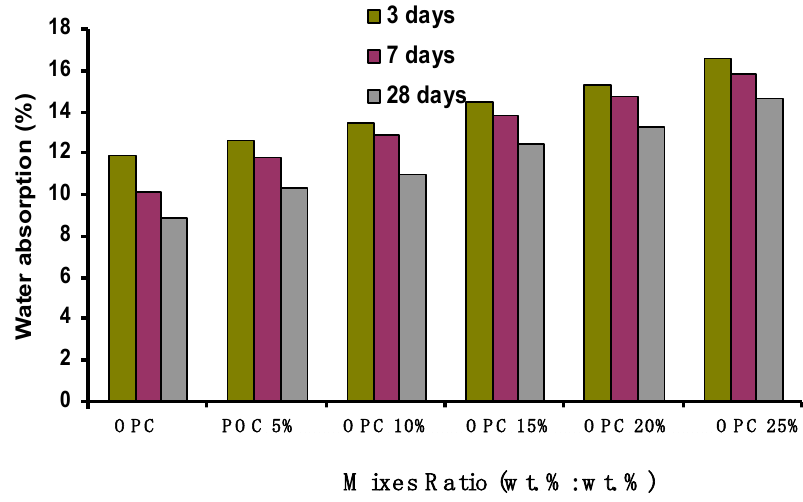
Figure 5. Water absorption of OPC and their mixes ratio with CMW.